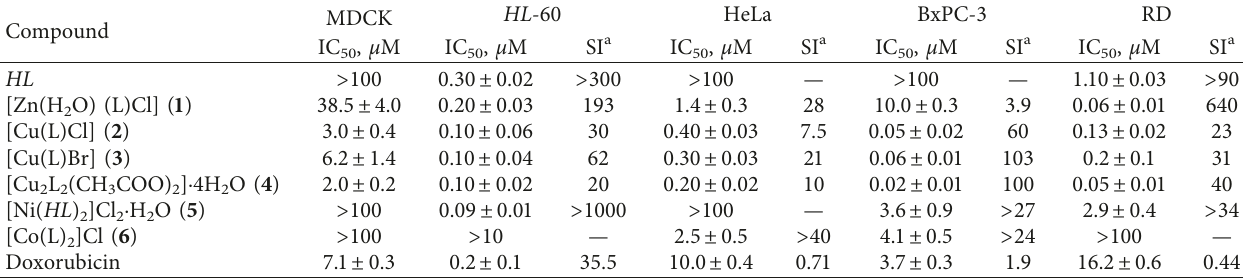
Table 4: IC 50 values of HL thiosemicarbazone and complexes 1 – 6 toward MDCK, HL-60, HeLa, BxPC-3, and RD cell lines. Compound